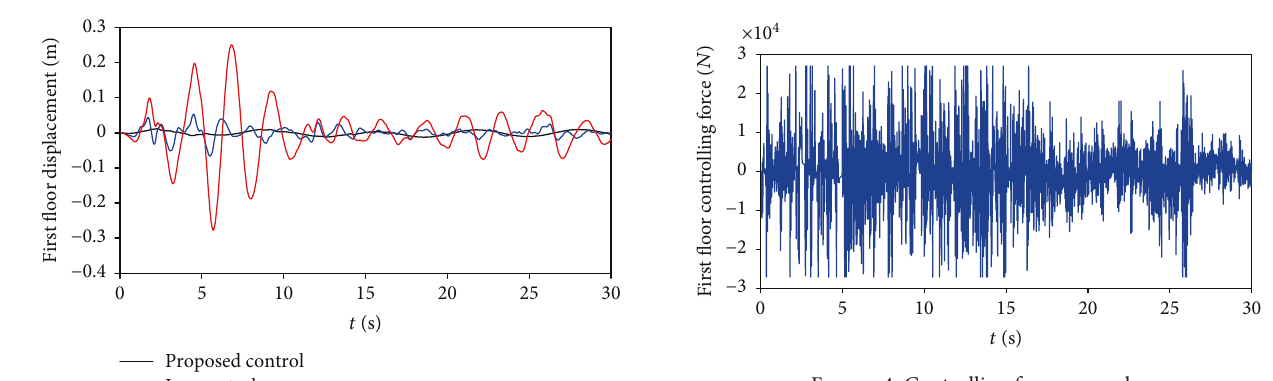
Figure 4: Controlling force example. Table 1: Maximum displacement, velocity, and acceleration of fi rst fl oor for